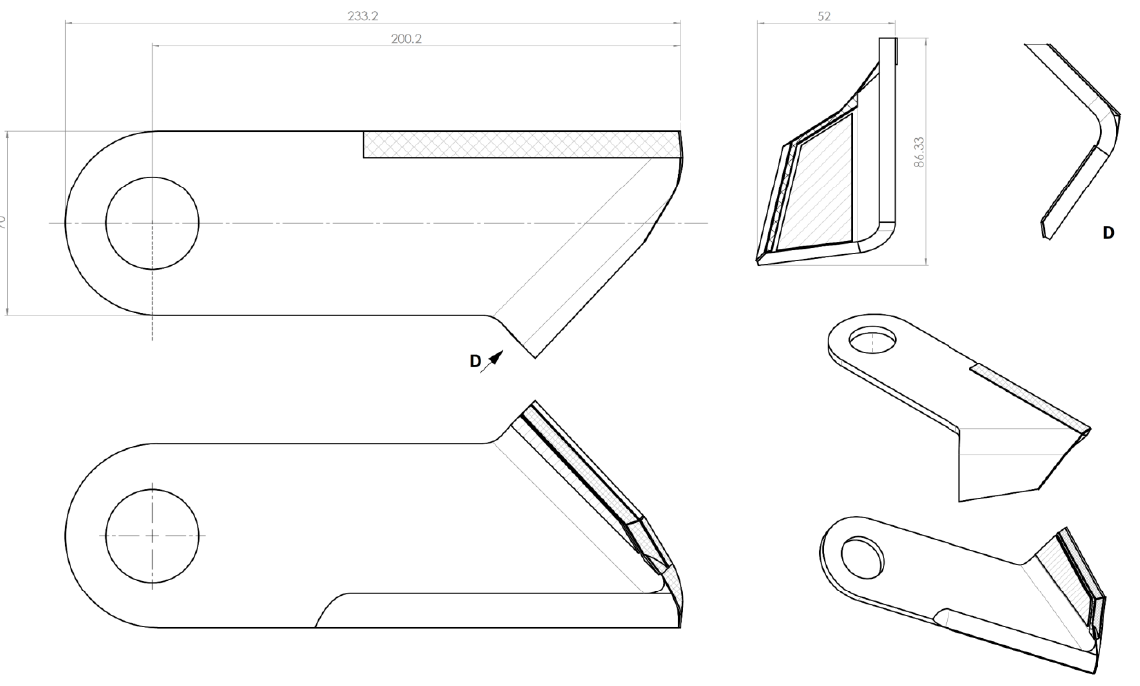
Figure A1. Structural diagram of the flail knife (Adapted with permission from Carl Geringhoff GmbH & Co. KG, 2023).